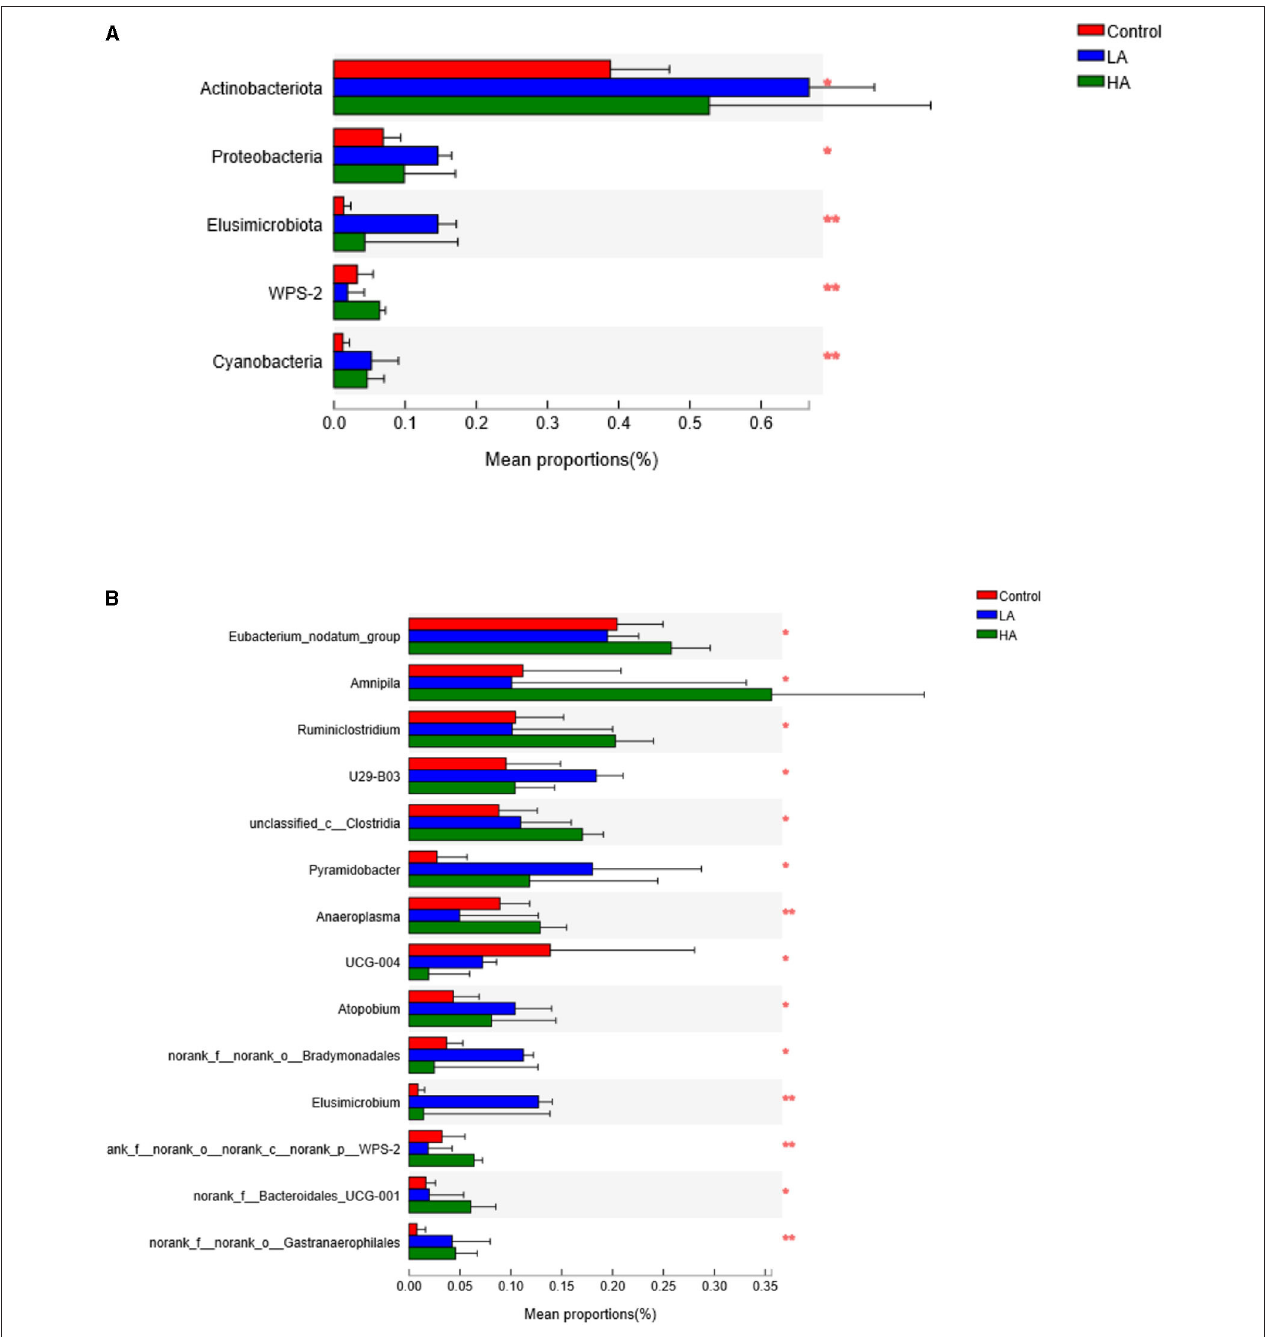
FIGURE 4 | Analysis of the significant differences of microbiota composition ( < 1%). (A) Phylum level. (B) Genus level. * P < 0.05, ** P < 0.01. LA = basal diet + 0.5-g/d PCP; HA = basal diet + 1-g/d